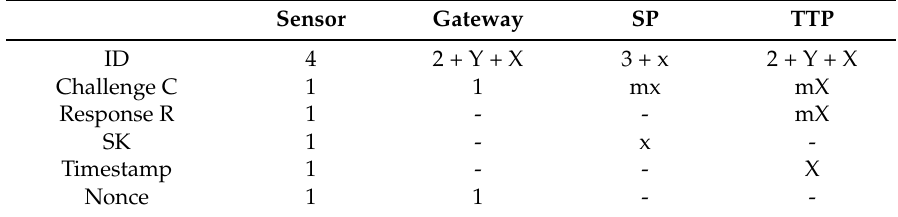
Table 5. Comparative storage resource analysis between communication